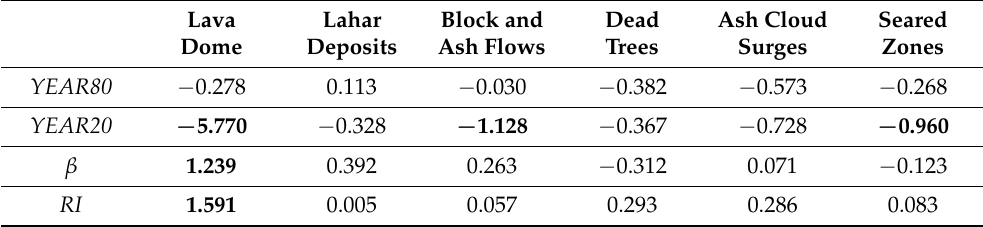
Figure 6. Spatial distribution of r 2 values ( A ) and p -values ( B ) from linear-log regression fitting. Note the color bar inversion in ( B ).